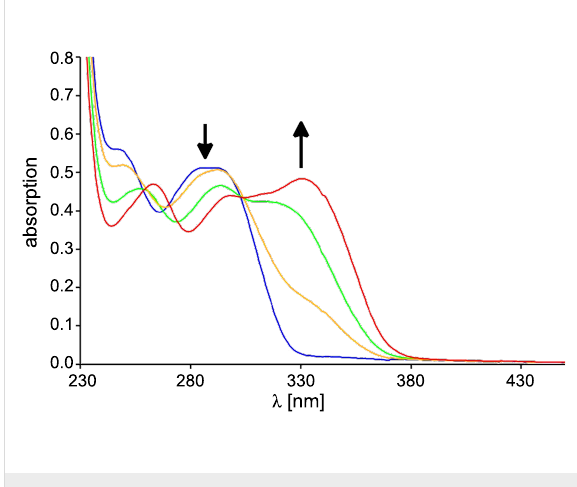
Figure 4: UV spectral change of 3-methylpyridine 7 (blue) in dichloro- methane (c = 5.6 × 10 –5 M) at 20 °C upon addition of 1 (yellow), 2.5 (green) and 20 equiv TFA ( 8 , red).